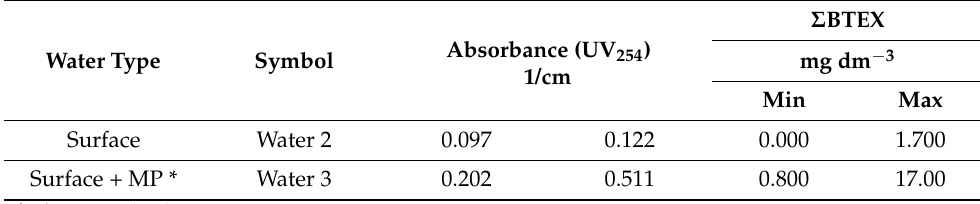
Table 2. Concentrations of tested hydrocarbons in individual test